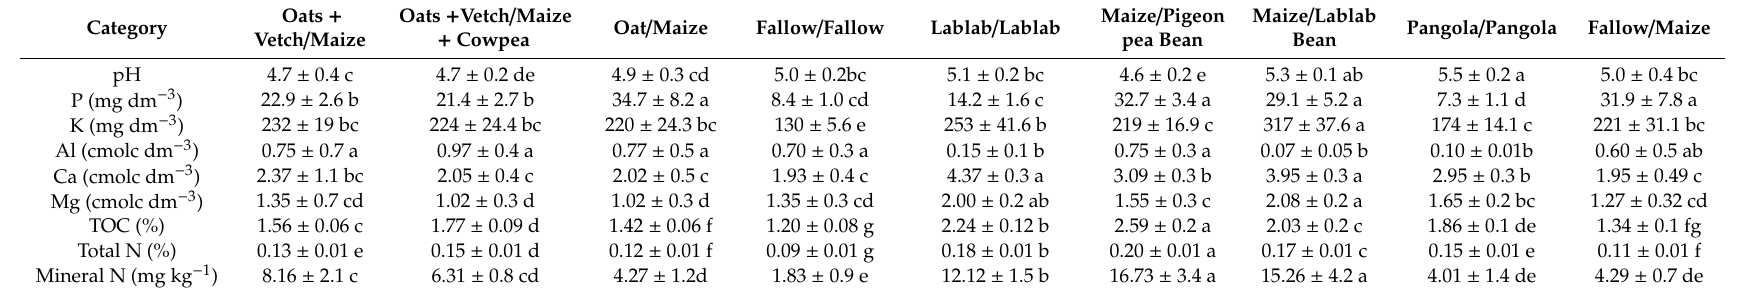
Table 1. Soil chemical features under di ff erent no-till cropping systems. Values presented are a mean from n = 4 values. Lower-case letters denote significant di ff erences in a given soil variable according to the Tukey’s test ( p ≤